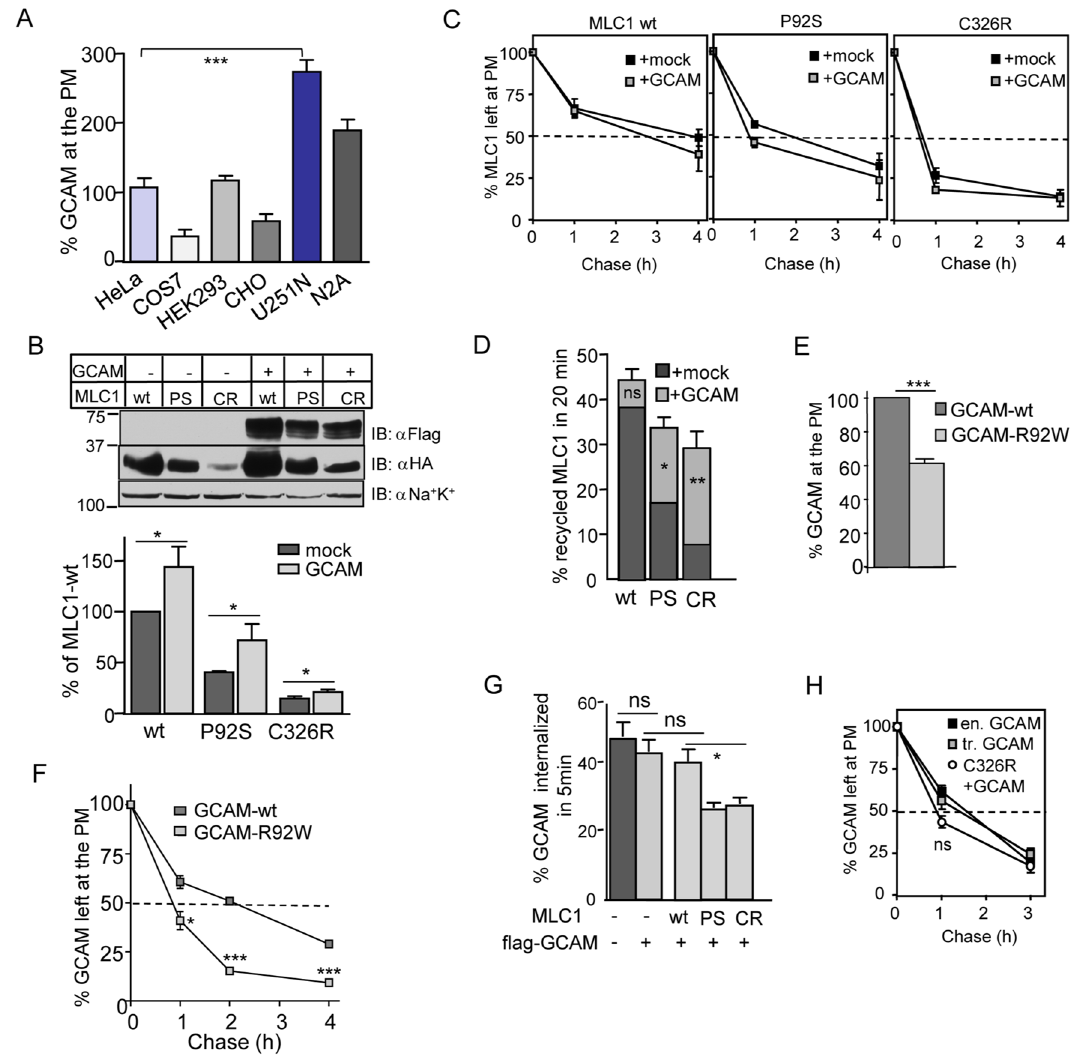
Figure 2. Early endocytic crosstalk of GlialCAM and MLC1 trafficking dynamics. ( A ) The relative PM density of endogenous GlialCAM (GCAM) was measured using cs-ELISA in indicated cell lines and expressed as a percentage normalized for cellular proteins. ( B ) GCAM effect to increase the cellular expression of MLC1 variants (wt, P92S, C326R) was determined by immunoblotting (n = 8). ( C ) The PM stability of MLC1 variants was measured using cs-ELISA in the presence or absence of exogenous GCAM. ( D ) Exogenous GCAM enhances MLC1 variants [wt, P92S (PS), C326R (CR)] endosomal recycling, which was measured using cs-ELISA as described in “Materials and methods”. ( E , F ) The PM expression ( E ) and stability ( F ) of GCAM-wt and disease-causing GCAM-R92W were determined using cs-ELISA. GCAM-R92W (~ T 1/2 < 1 h) was destabilized when compared to its wt counterpart (~ T 1/2 2 h). ( G ) The impact of MLC1 variants [wt, P92S (PS), C326R (CR)] expression on the GCAM internalization was measured using cs-ELISA. ( H ) Comparison of the PM stability between overexpressed (tr) GCAM and endogenous GCAM (en) and upon coexpression of MLC1- C326R was measured using cs-ELISA. Means ± SEM, n ≥ 3, *p < 0.05, **p < 0.01, ***p <